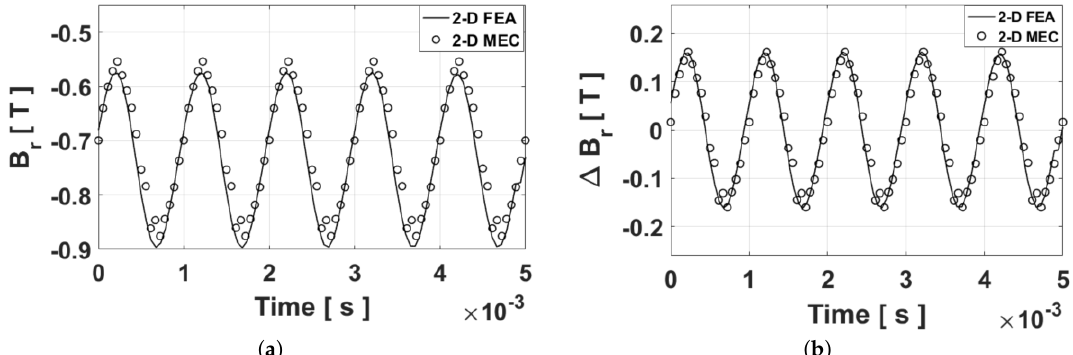
Figure 17. Validation of the radial component of B in the middle of the North PM: ( a ) with and ( b ) without average value.